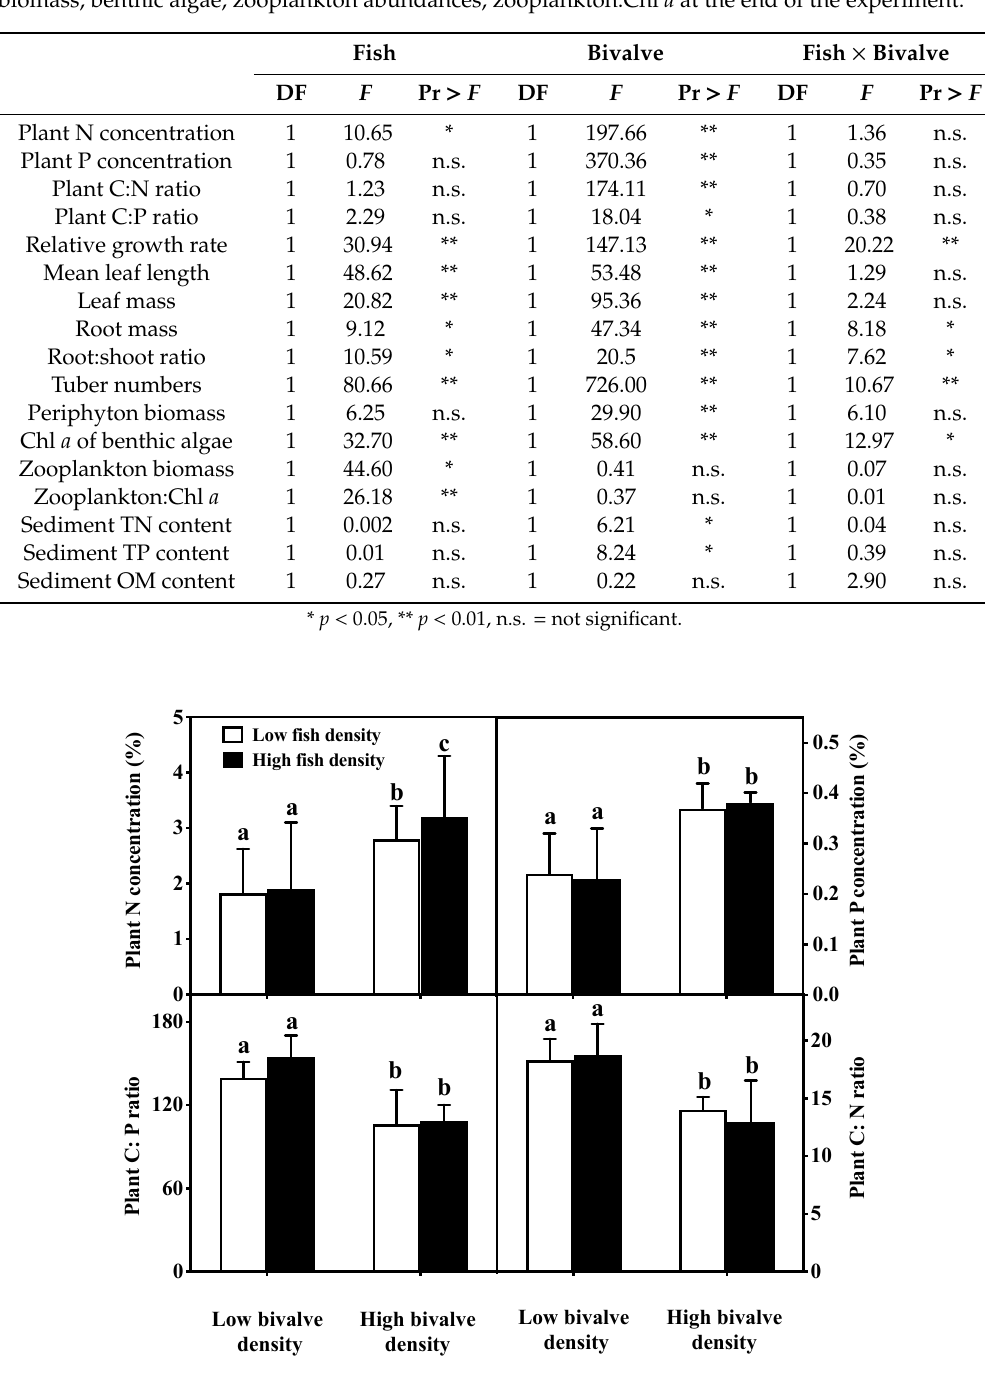
Figure 6. Nitrogen (N), phosphorus (P) and the carbon:phosphorus (C:P) and carbon:nitrogen (C:N) ratios of Vallisneria natans in the di ff erent treatments at the end of the experiment (means ± SD). Di ff erent letters show significant di ff erences among